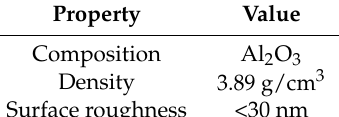
Table 1. Properties of the ceramic plate.